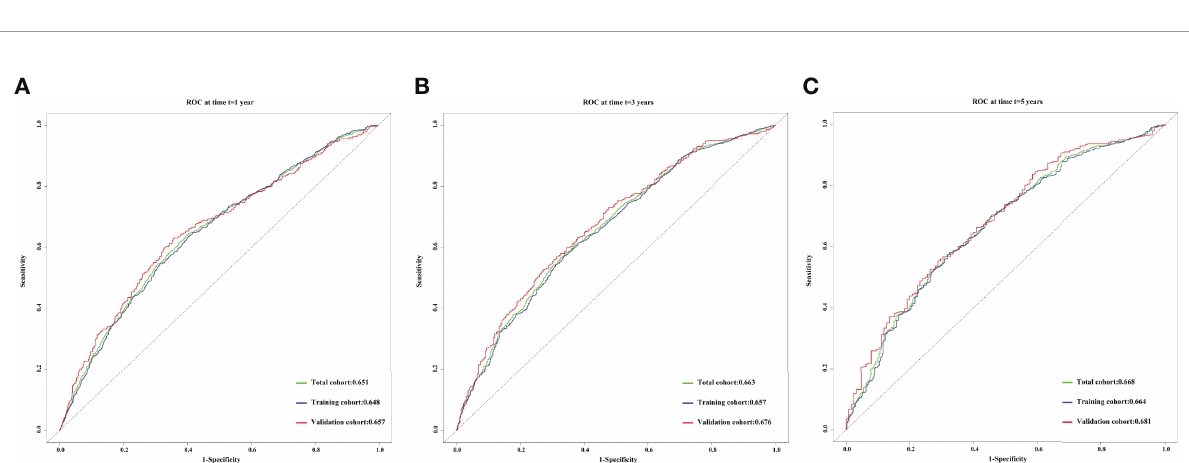
model 3: P < 0.001, HR = 1.72, 95% CI = 1.51 – 1.95) groups had worse OS in patients with cancer ( Table 3 ). We performed a sensitivity analysis of the total cohort, and the results remained consistent ( Table S1 ).